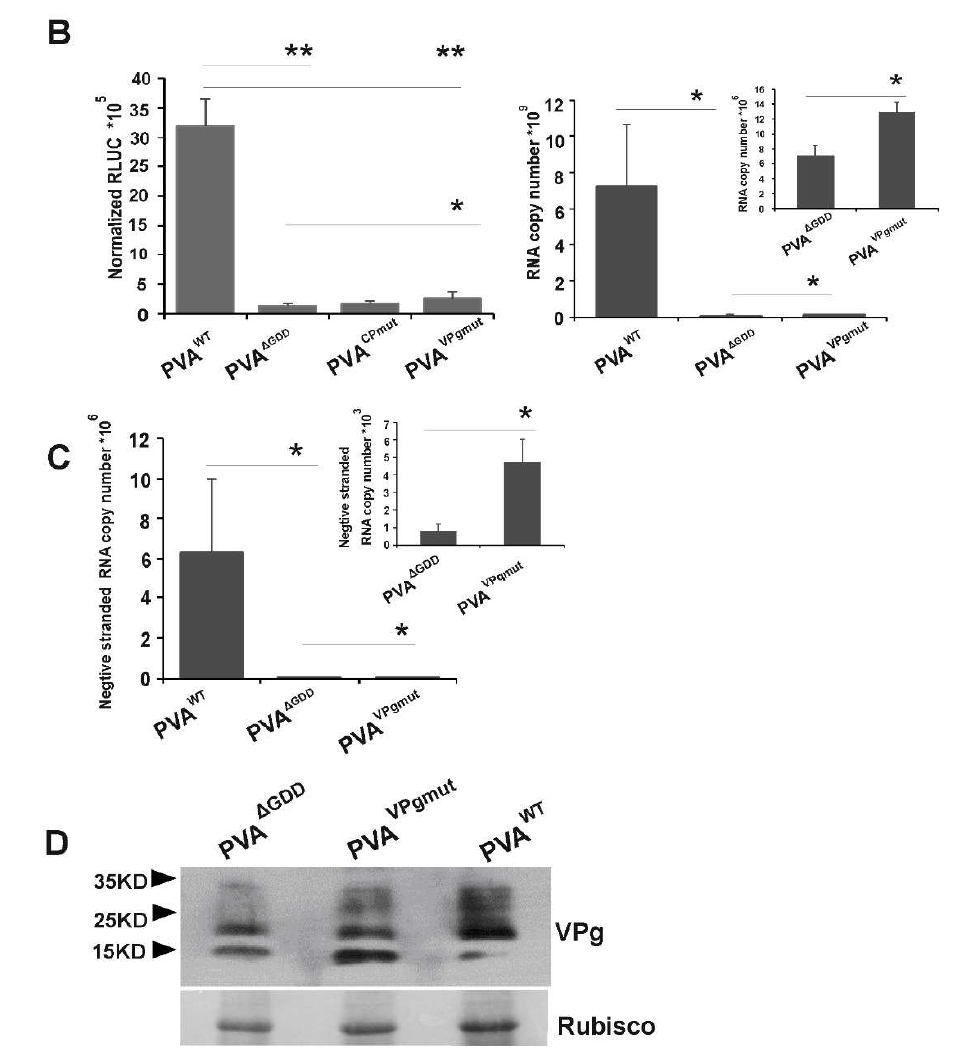
Figure 2. Viral replication occurs in PVA VPgmut -expressing Nicotiana benthamiana cells. ( A ) A schematic representation of PVA RNA prior to replication and after the first round of replication in Agrobacterium -infiltrated N. benthamiana leaves. Importantly, PVA RNAs appear from the nucleus as capped transcripts and only after the first round of replication carry VPg at their 5’end. ( B , C ) PVA WT , PVA ∆ GDD , PVA CPmut and PVA VPgmut cDNAs were Agrobacterium -infiltrated into N. benthamiana leaves at OD 600 0.05. In ( B ), samples were collected at 3 dpi followed by a luciferase assay to determine virus-derived Renilla luciferase (3’RLUC) activity (left panel; ( n = 4)) and qRT-PCR to quantitate viral RNA accumulation (right panel; ( n = 4); PVA CPmut RNA accumulation was not determined). In ( C ), samples were collected at 4 dpi followed by the quantitation of PVA (-)-strand RNA accumulation ( n = 4). The significance of the di ff erences between the constructs in representative experiments was calculated by a Student’s t -test with pair-vice comparisons, as indicated in the figure. p -values < 0.01 are indicated with ** and < 0.05 with *. ( D ) Samples collected from N. benthamiana leaves that were infiltrated with Agrobacterium carrying PVA WT , PVA ∆ GDD and PVA VPgmut cDNAs (OD 600 0.05) at 3 dpi were subjected to a Western blot analysis with anti-VPg antibodies to verify VPg / VPg mut